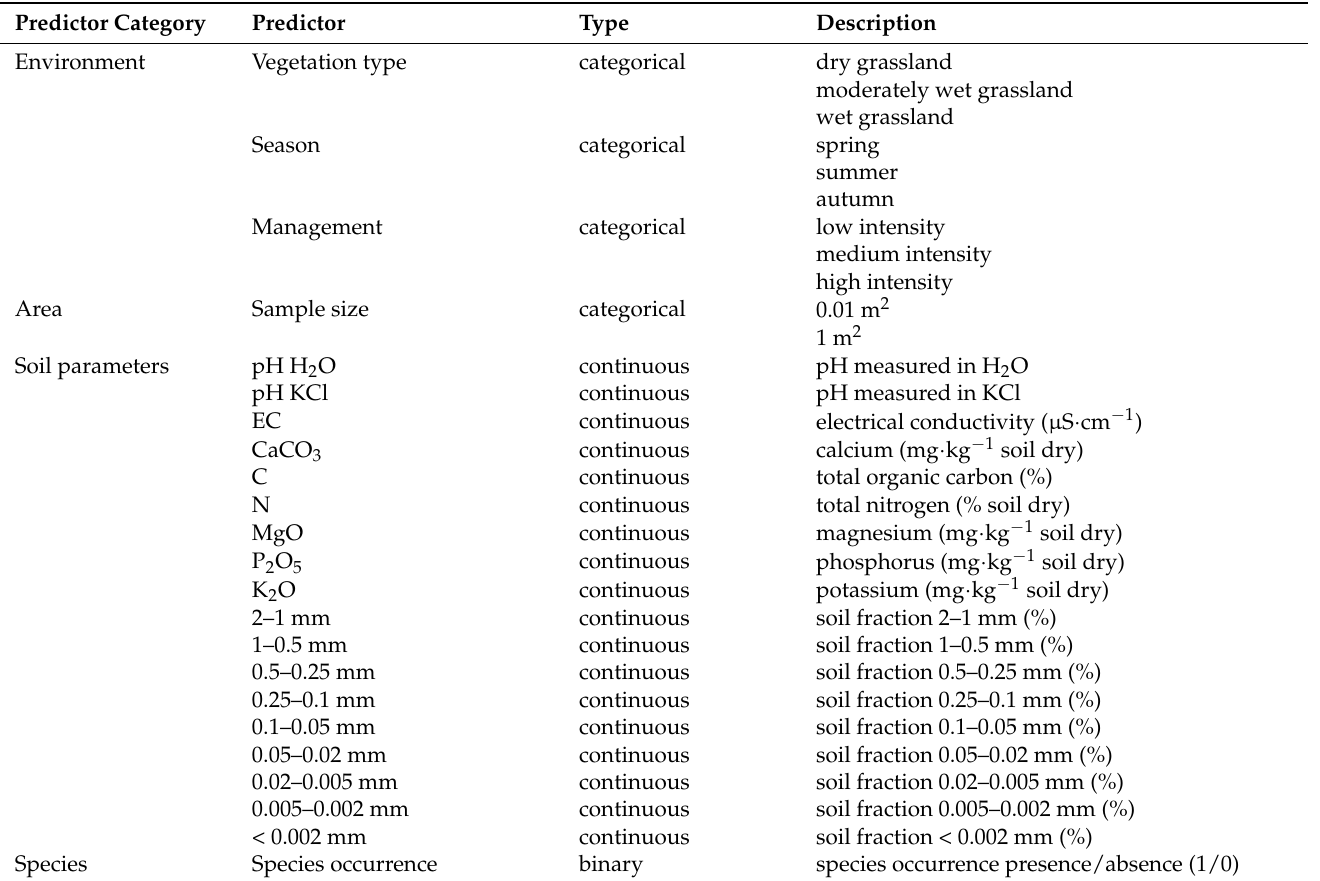
Table 1. List of predictors used in this